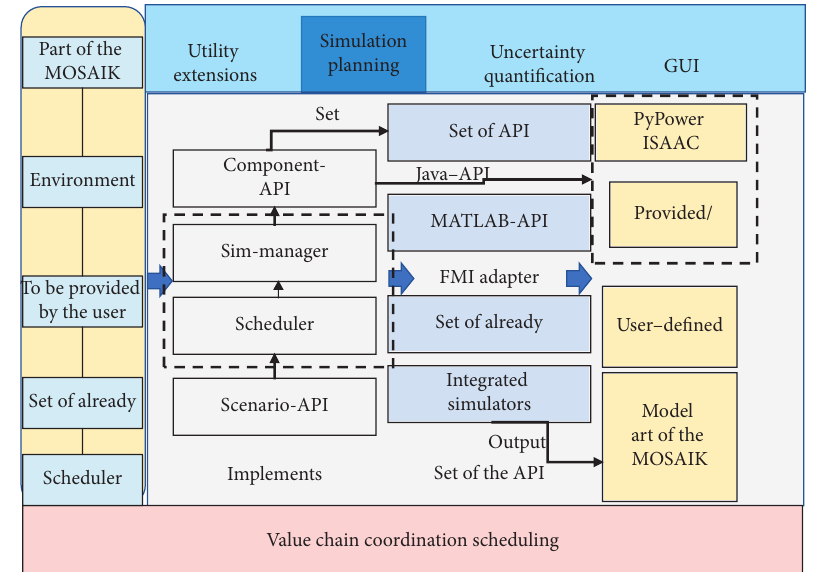
Figure 4: Cooperative scheduling model of parts multivalue